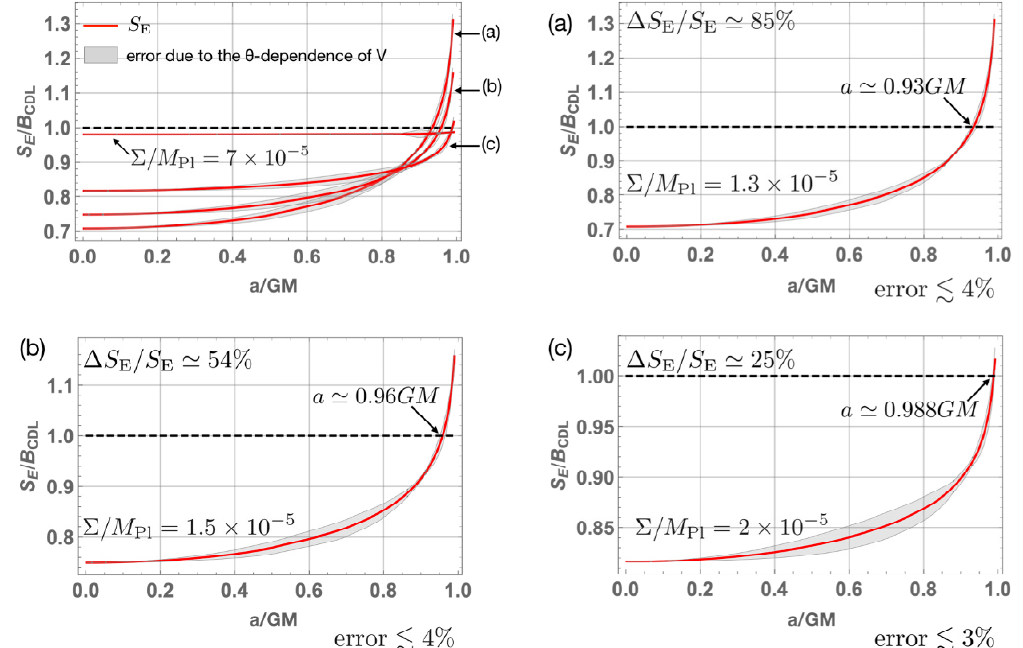
Figure 10 . The spin-dependence of the Euclidean action S E = S E ( a ) while the parameters are (cid:12)xed as r s = 10 3 ‘ Pl , H = 1 (cid:2) 10 (cid:0) 4 M Pl , (a) (cid:6) =M Pl = 1 : 3 (cid:2) 10 (cid:0) 5 , (b) 1 : 5 (cid:2) 10 (cid:0) 5 , and (c) 2 (cid:2) 10 (cid:0) 5 . The black dashed lines show S E = B CDL . Here we de(cid:12)ned (cid:1) S E =S E (cid:17) ( S E ( a = 0) (cid:0) S E ( a = 0 : 99 GM )) =S E ( a = 0). For the comparison, the action for (cid:6) = 7 (cid:2) 10 (cid:0) 5 M Pl is also shown in the upper left